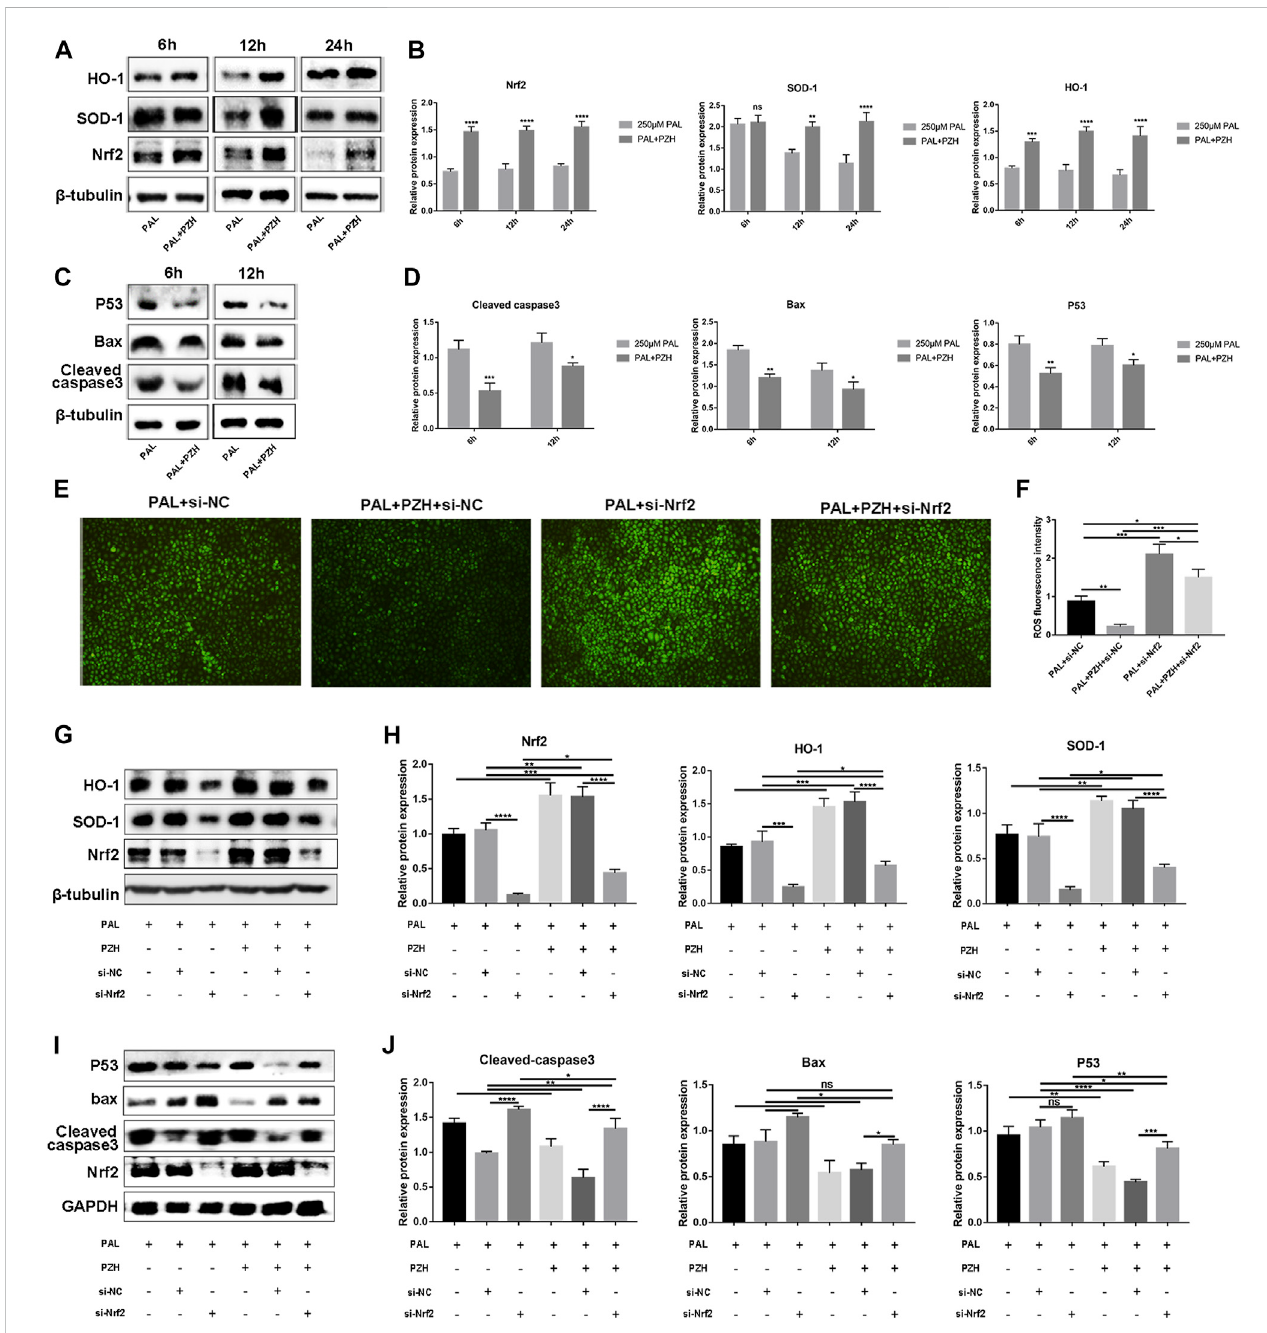
FIGURE 6 PZH attenuates PAL-induced oxidative stress and apoptosis in HUVECs via activating the Nrf2/ARE pathway. Knockdown of Nrf2 abolishes the anti- oxidative, and anti-apoptosis effects of PZH on HUVECs treated with PAL. (A – F) Effect of 0.1 mg/ml PZH on the expression and quantitative analysis using ImageJ of Nrf2 pathway-related proteins (A,B) and apoptotic proteins (C,D) at different hours in HUVECs treated with 250 μ M PAL. **** p < 0.0001, *** p < 0.001, ** p < 0.01, * p < 0.05 (n = 3). (E,F) The effects of Nrf2 knockdown on the anti-oxidative stress of PZH in HUVECs were determined by DCFH-DA staining to detect the ROS level (E) , the fl uorescent intensity (F) was quanti fi ed by ImageJ * p < 0.05, ** p < 0.01, *** p < 0.001, (n = 3). (G,H) Protein expression andquantitativeanalysisusingImageJofNrf2/HO-1andSOD-1inHUVECstreatedwithNrf2-siRNA.* p < 0.05,** p < 0.01,*** p < 0.001,**** p < 0.0001(n=3). (I,J) ProteinexpressionandquantitativeanalysisofBax,p53,andcleavedcaspase-3inducedby0.1 mg/mlPZHinHUVECsculturedin250 μ MPALandtreated with Nrf2-siRNA. * p < 0.05, ** p < 0.01, *** p < 0.001, **** p < 0.0001 (n = 3). Data are expressed as the mean ±